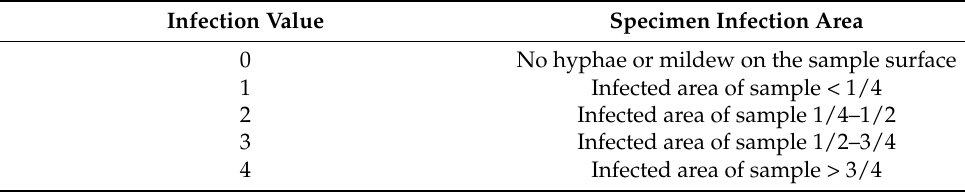
Table 2. Classification standard of surface infection levels of samples.